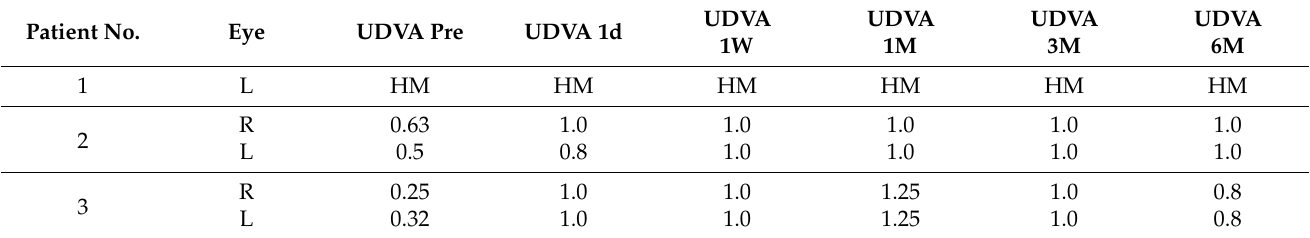
Table 2. Preoperative UDVA versus postoperative UDVA up to six-month follow-up. HM indicates that UDVA was not measurable on the Snellen scale, yet the patient perceived hand motion at 50 cm